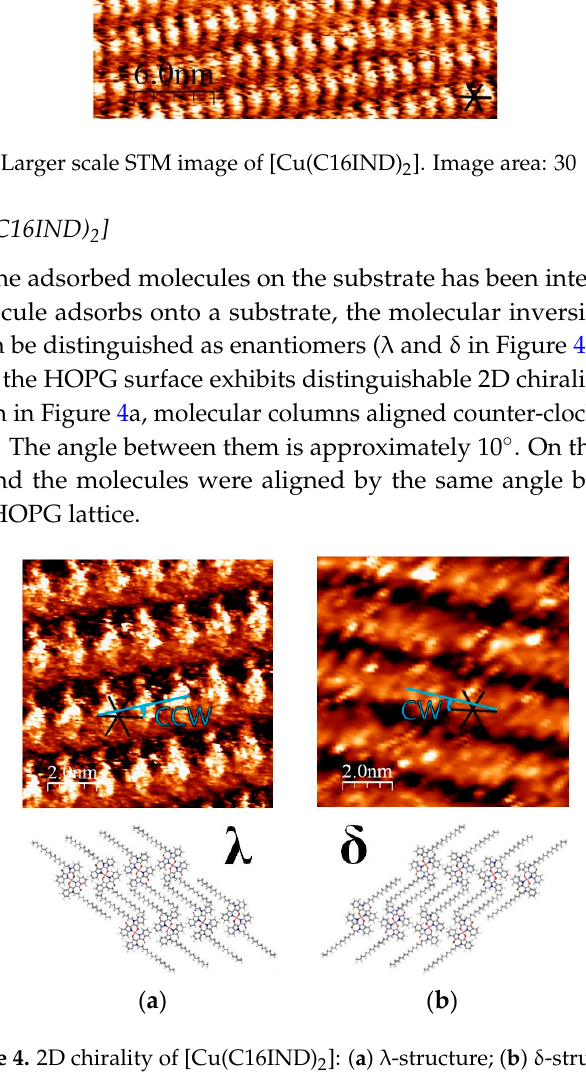
λ -structure; ( b ) δ 2 ]: ( a )